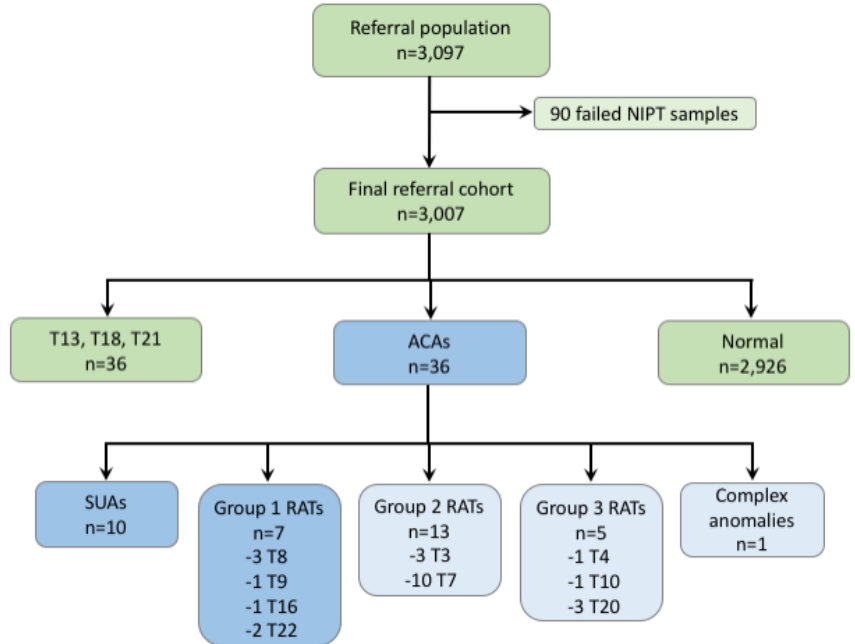
Figure 2. Overview of the referral population, failed samples, and final referral cohort. T, trisomy; ACAs, atypical chromosomal anomalies; SUAs, structural unbalanced anomalies; RATs, rare autosomal trisomies. Table 5. NIPT indications for the referral population.